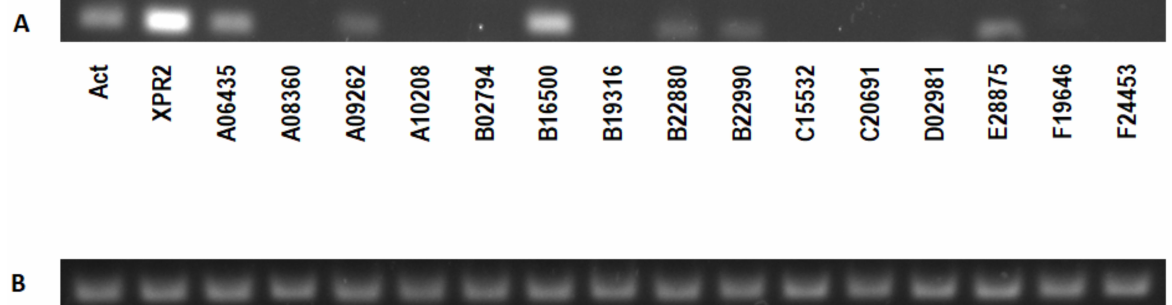
Figure 3. ( A ) Expression of alkaline proteases in Y. lipolytica W29 growing on BSG medium, ( B ) Verifi- cation of primers on genomic DNA. The numbers correspond to the analyzed genes, XPR2 refers to the alkaline extracellular protease, and Act refers to actin gene.